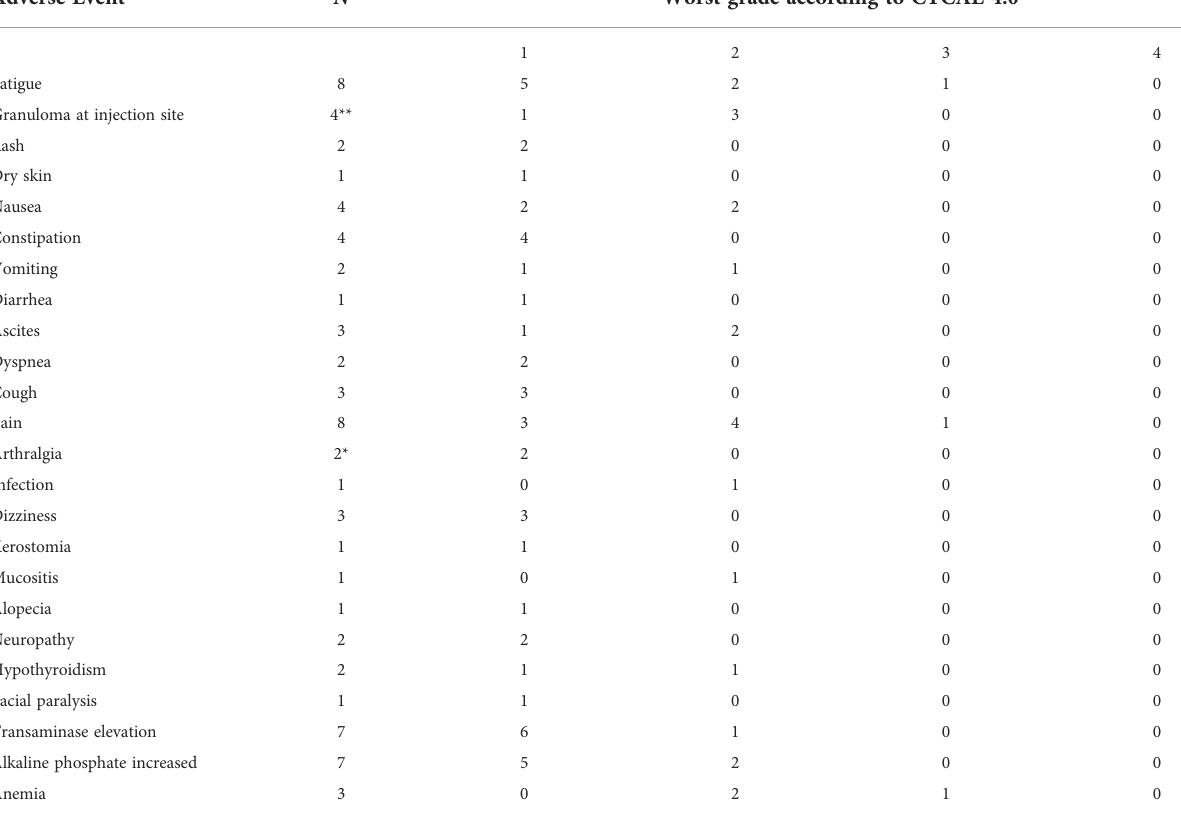
TABLE 2 A list of registered adverse events. Adverse Event N Worst grade according to CTCAE